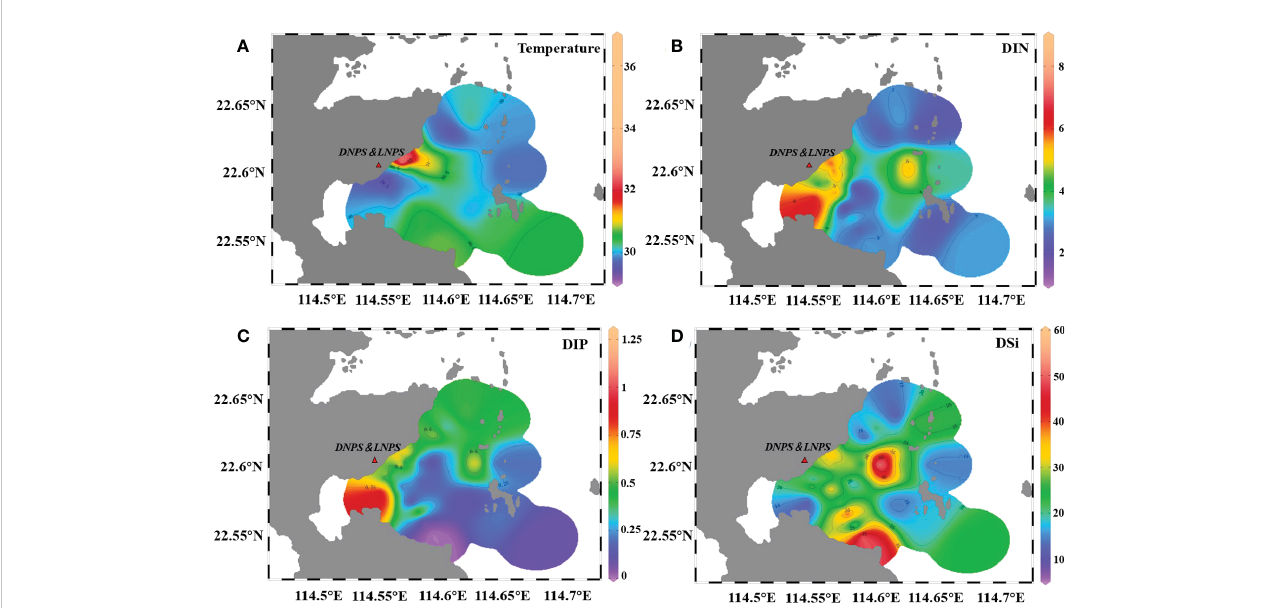
FIGURE 2 Sea surface temperature ( A , °C) and nutrient ( m mol L -1 ) distribution in the survey area. DIN represents the total concentration of NO 3 - and NO 2 - . (B) DIP represents the concentration of PO 4- (C) , and DSi represents the concentration of SiO 4- (D)